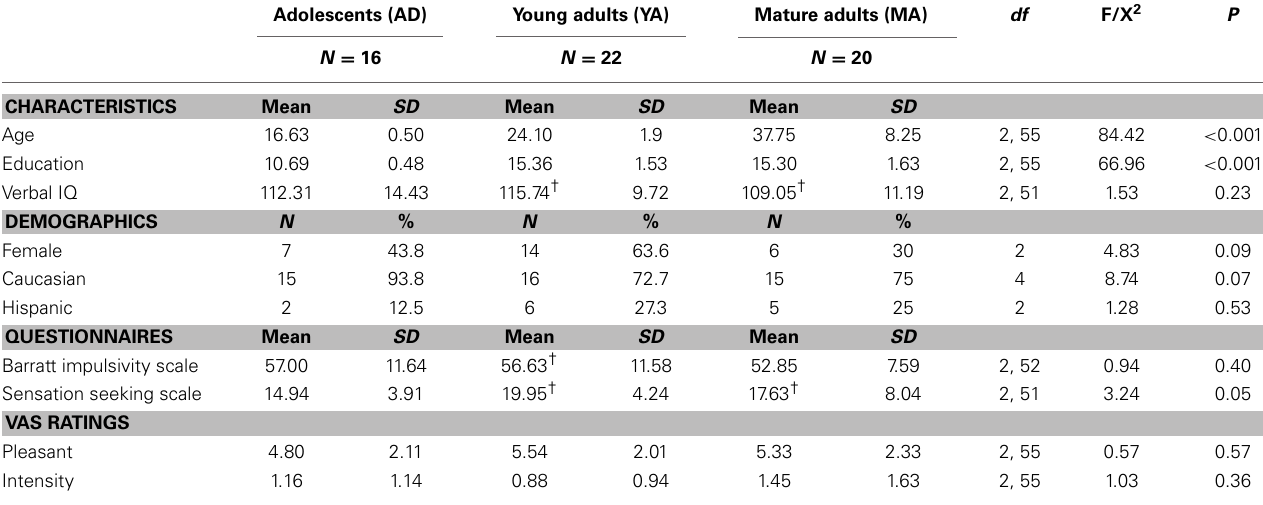
Table 1 | Subject characteristics by group.